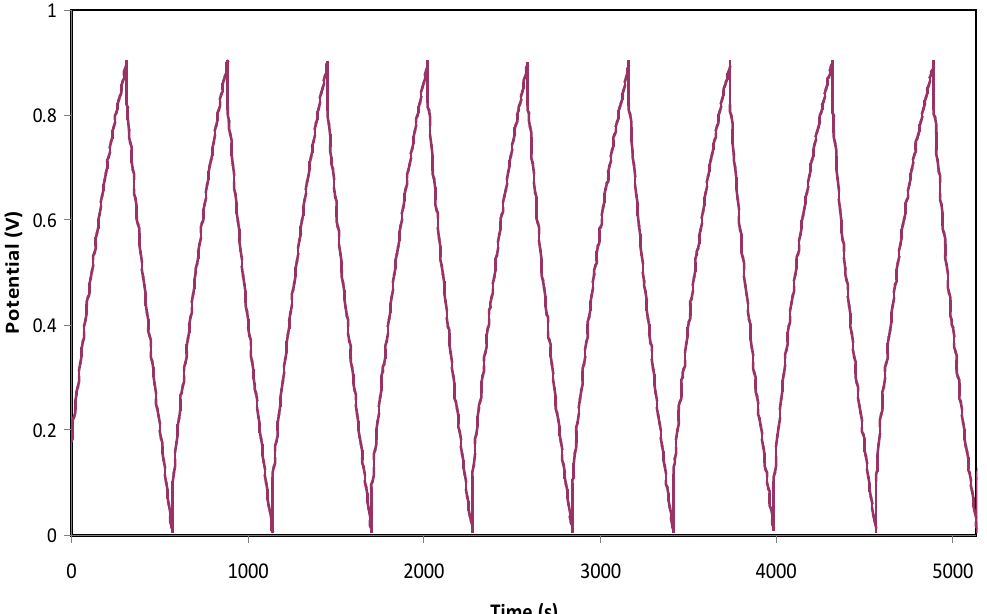
Figure 7. Charge-discharge profile of the fabricated EDLC at selected cycles.